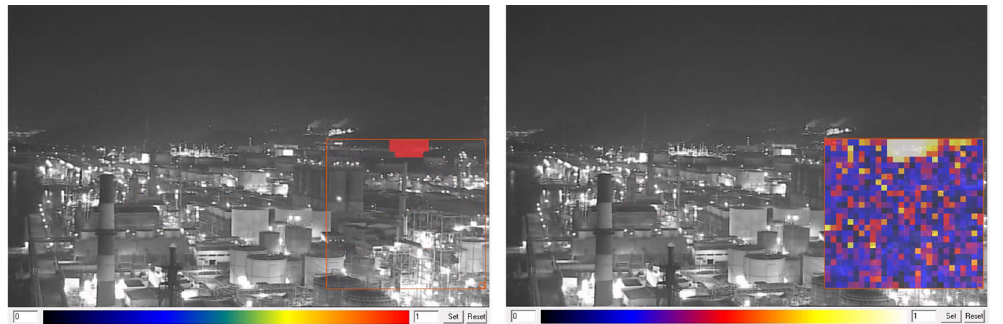
Figure 2. The identification image ( left ) and the coefficient of correlation image ( right ) for the instance when ammonia was detected by the SIGIS-2 installed at the Jeongnyang site (Date: 21 September 2022 at 22:57 GMT+9).